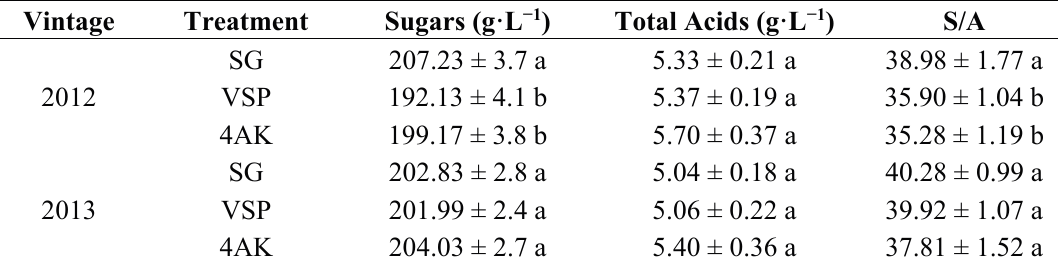
Data represent mean value ± SD for three replicates. Different letters within a column for the same year indicate significant differences between treatments calculated by Duncan’s test ( p < 0.05). S/A, ratio of total soluble sugars to titratable